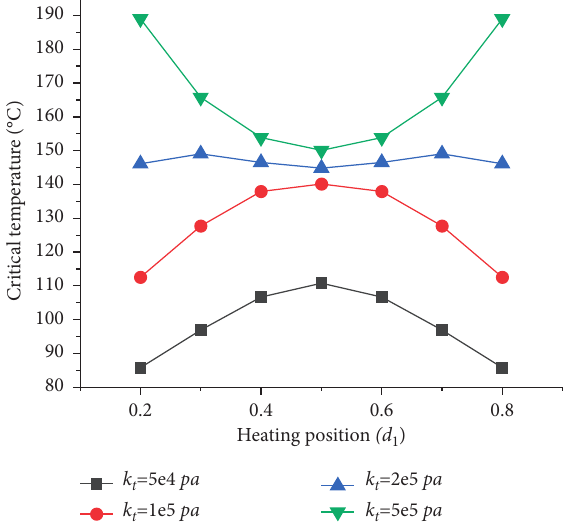
Figure 5: Critical temperatures of composite laminated plates with different heating